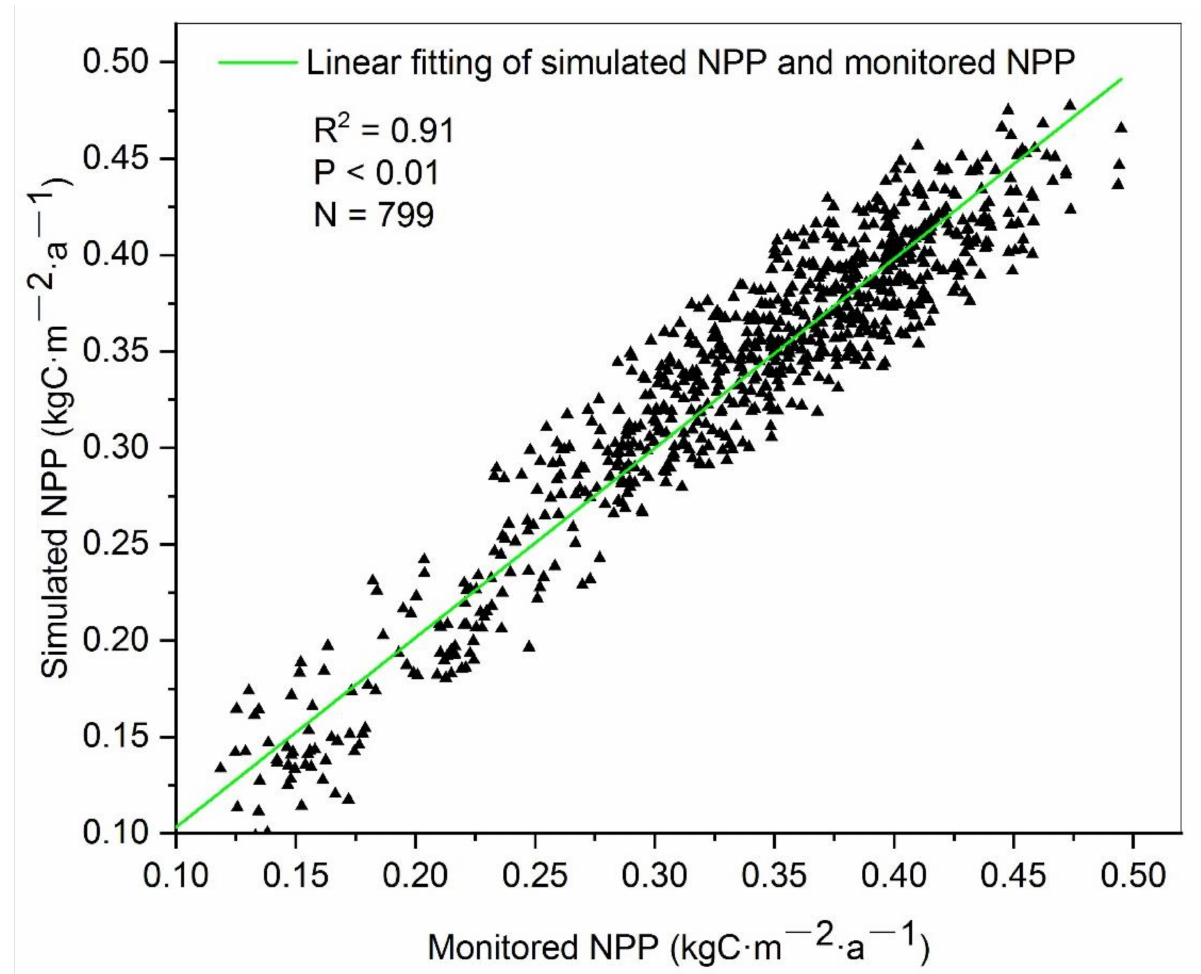
Figure 4. A comparison of simulated NPP with monitored